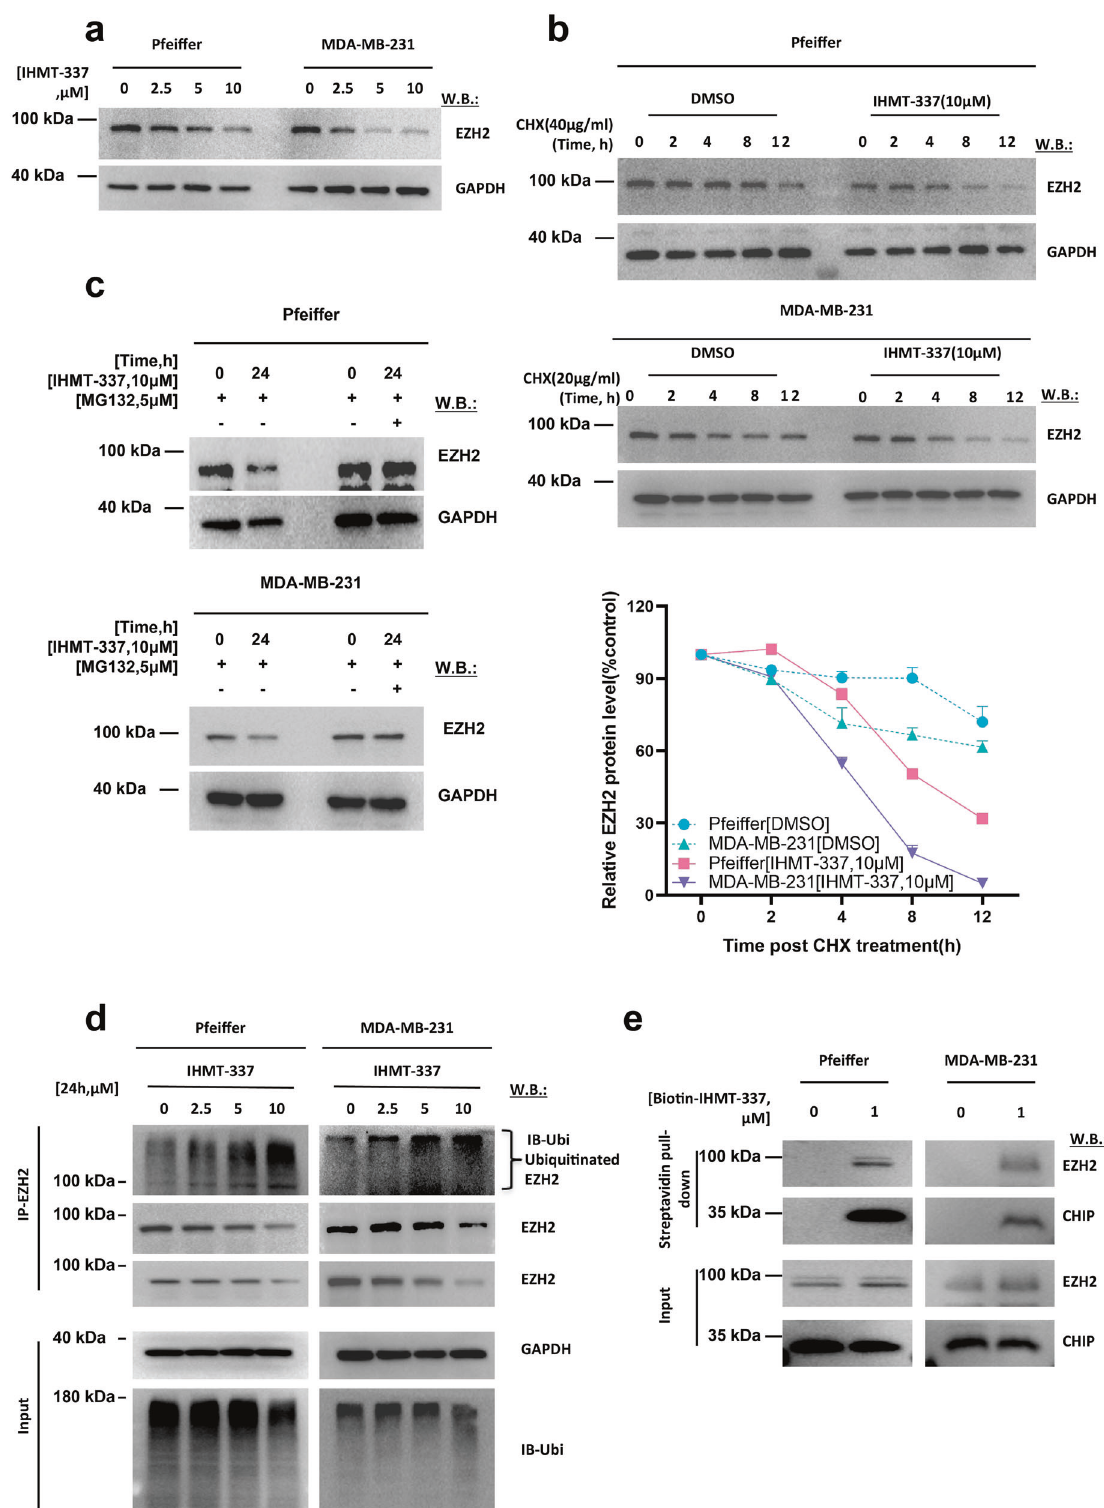
cell cycle defect during the treatment of IHMT-337, we applied a CUT&Tag-based proteomic approach and found that EZH2 binds to the upstream region of CDK4 gene. Therefore, EZH2 associates with CDK4 promoter to regulate its transcription, suggesting that EZH2 may play as a transcriptional factor of CDK4 in TNBC (Fig. 4d). Signal Transduction and Targeted Therapy (2023)